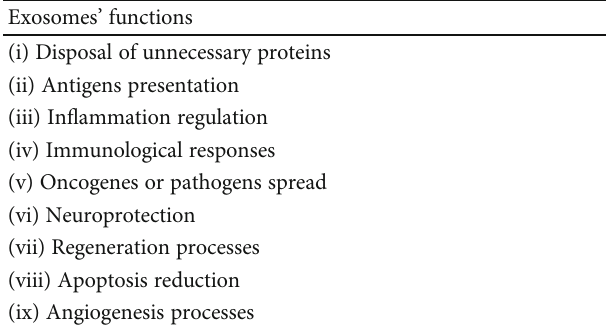
Table 1: Functions of exosomes. Exosomes ’